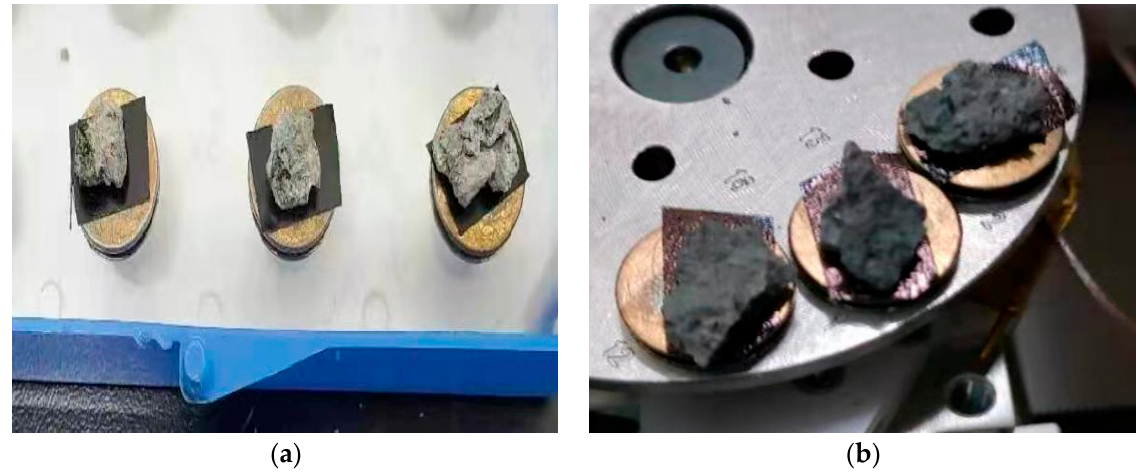
Figure 10. Operation flow of SEM: ( a ) Sample preparation; ( b ) Gold spray coating.